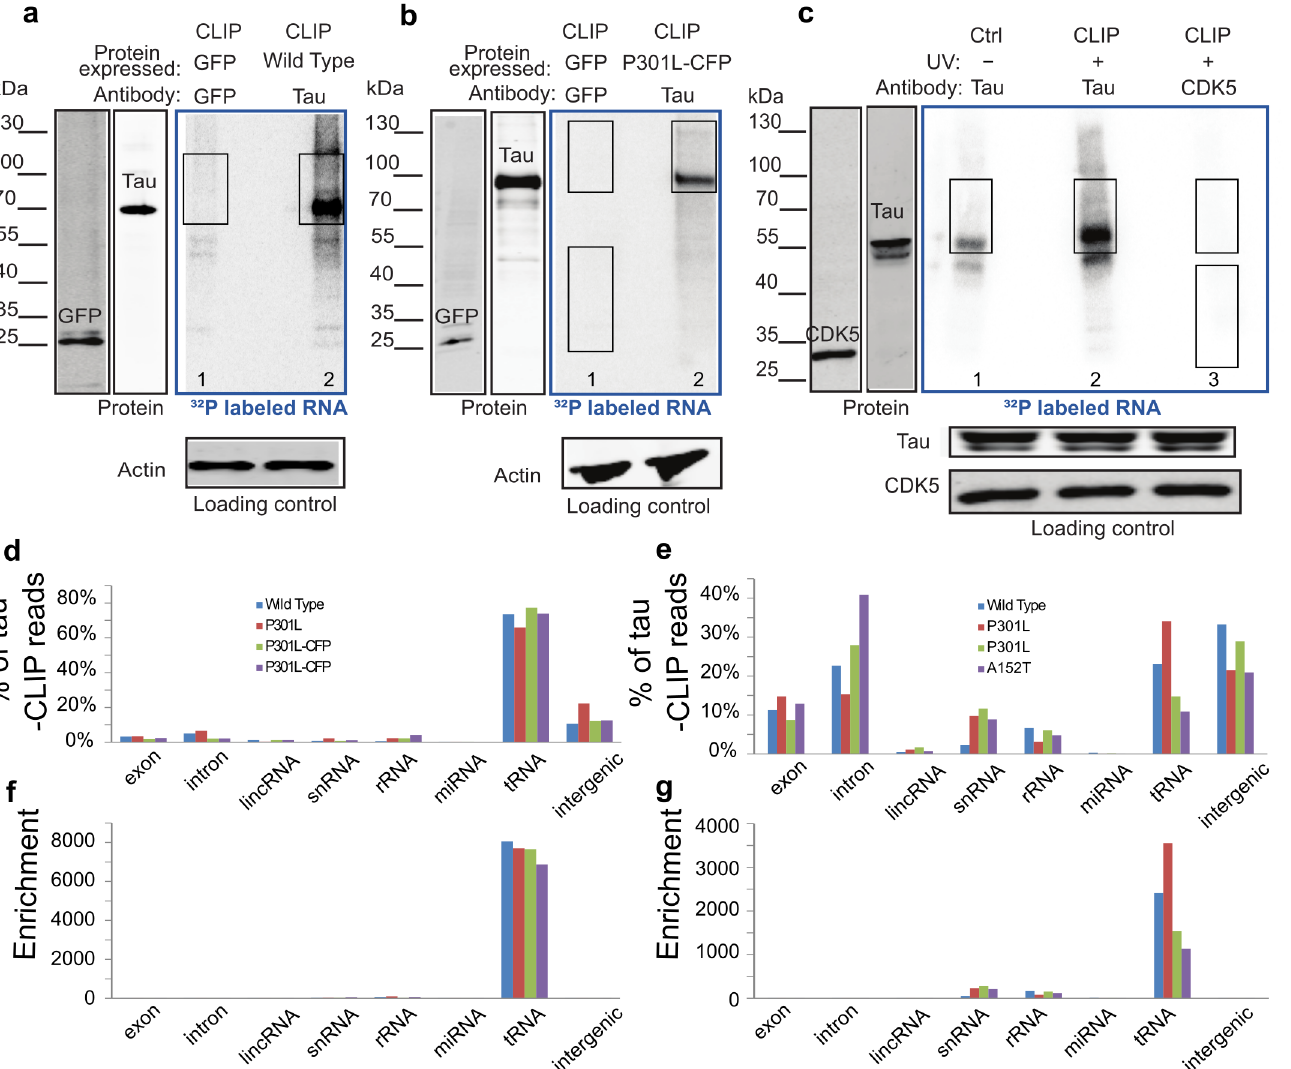
Fig 1. Tau PhotoActivatable Ribonucleoside-enhanced Individual-nucleotide resolution UV Cross-Linking ImmunoPrecipitation and high- throughput sequencing (PAR-iCLIP) in tau-expressing human embryonic kidney cells (HEK) and human-induced pluripotent stem cell (hiPSC) -derived neurons. Phosphor images in the blue frames (A-C) show 32 P-labelledRNA crosslinkedto tau protein in HEK cells expressingtau (A-B) and in hiPSC-derived neuronswith endogenoustau (C). PAR-iCLIP in HEK cells expressingwild-typetau (A, lane 2) or tau P301L-CFP (B, lane 2; nota bene: the fused cyan fluorescent protein [CFP] retards the migration of tau). (C) PAR-iCLIP of endogenous wild-typetau in hiPSC-derived neurons (C, lane 2). The antibodiesanti-tau HJ 8.5, anti-greenfluorescence protein (GFP) and anti- Cyclin–dependent kinase 5 (CDK5) were used for protein precipitation.No RNase was added, unless specified.PAR-iCLIP with GFP as a control (A-B, lane 1), with CDK5 as a control (C, lane 3) and no UV control (C, lane 1). A small RNA signalwas visible in the absenceof cross-linking (no UV control) in hiPSC-derived neurons(C, lane1), suggesting a small portion of RNA may associate with tau in vitro after cell lysis. The RNA-protein complexesfrom Cross-Linking ImmunoPrecipitation (CLIP) marked by rectangles were cut from the blot for DNA library preparation. Note that 2 regions of GFP and CDK5 were cut out as sequencing controls in which the lower molecularweight (MW) band corresponds to GFP or CDK5. (D-E) Percentage of tau-CLIP reads that are mappedto 8 humangenome regionsin HEK cells (D) and hiPSC-derived neurons(E). (F-G) Enrichment of tRNA in tau-CLIP of HEK cells (F) and hiPSC-derived neurons(G) as discussedin text. The numerical data used in (D-G) are includedin S1 Data.